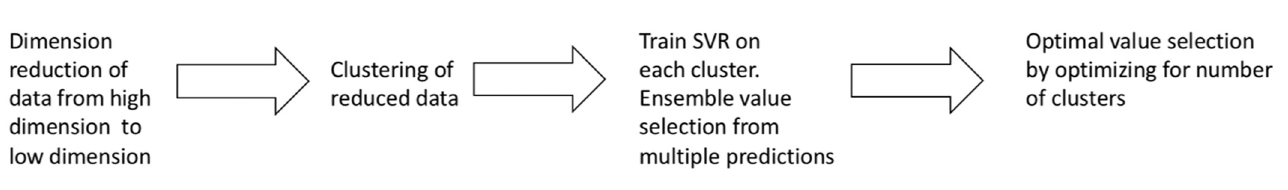
Figure 1. Overview of kESVR model.